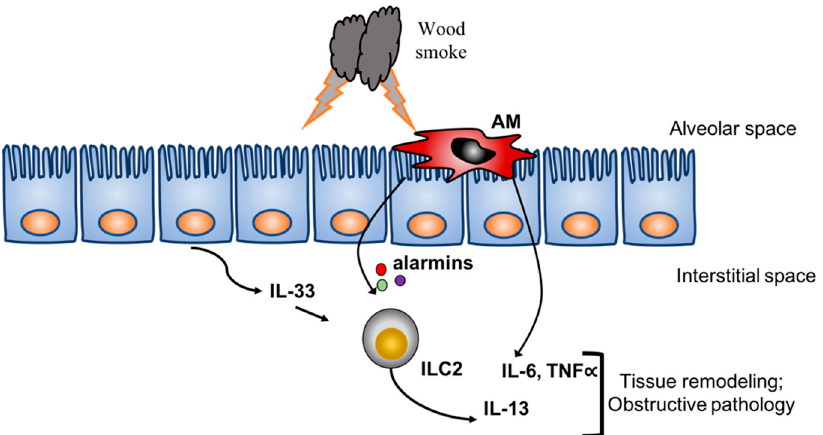
Figure 6. Theoretical molecular mechanism of the effects of wildfire smoke on pulmonary function. The working hypothesis is that both alveolar macrophages (AM) and lung epithelial cells directly interact with smoke particles. The combined responses result in production of key cytokines and alarmins that activate innate lymphoid cells (ILC2) and lung parenchyma resulting in tissue remodeling and an obstructive pathology (i.e., COPD, asthma).